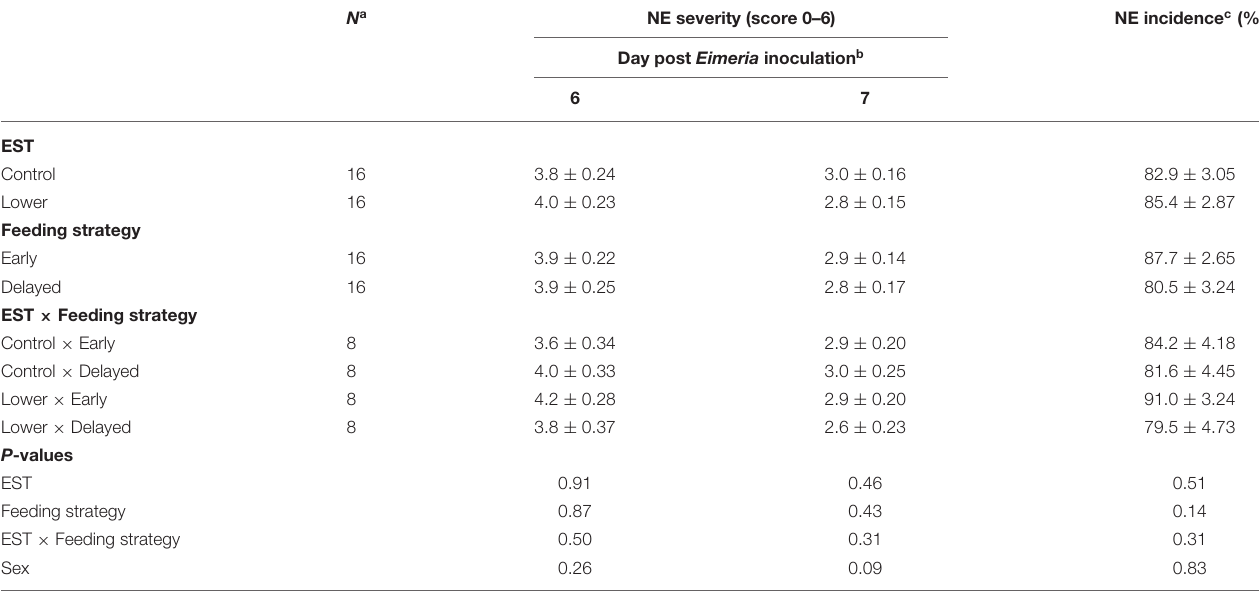
TABLE 2 | Effect of eggshell temperature ( EST ) during late incubation [ ≥ E17–E19.5; 37.8 ◦ C ( control ) or 36.7 ◦ C ( lower )] and/or feeding strategy after hatch [immediate access to feed and water ( early ) or 51–54-h deprivation ( delayed )] on necrotic lesions in the small intestine of broilers at d 6 or 7 post Eimeria inoculation (d 21 post hatch) to induce necrotic enteritis (mean ± SE).